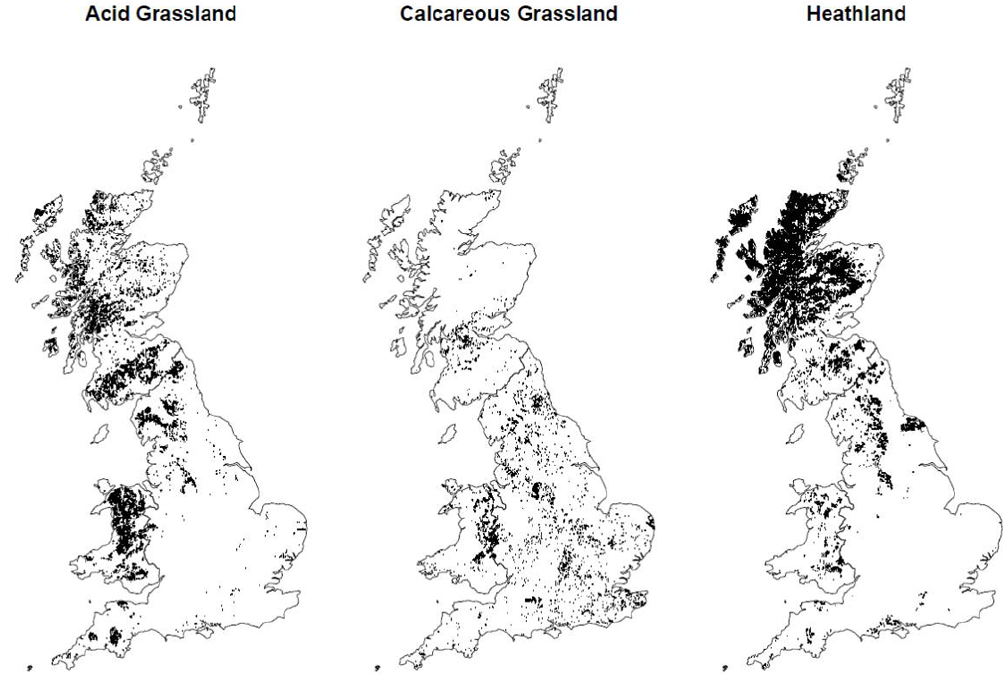
Fig. 8. Distribution of three semi-natural habitats: calcareous grassland; acid grassland; and heathland over Great Britain according to Land Cover Map 2000. Shown and mapped at 1km 2 resolution when habitat was dominant type in the 1km